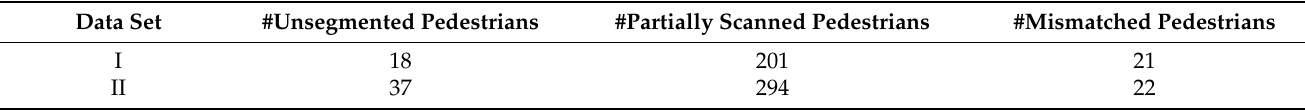
Table 3. Summary of missing pedestrians ( #: count of